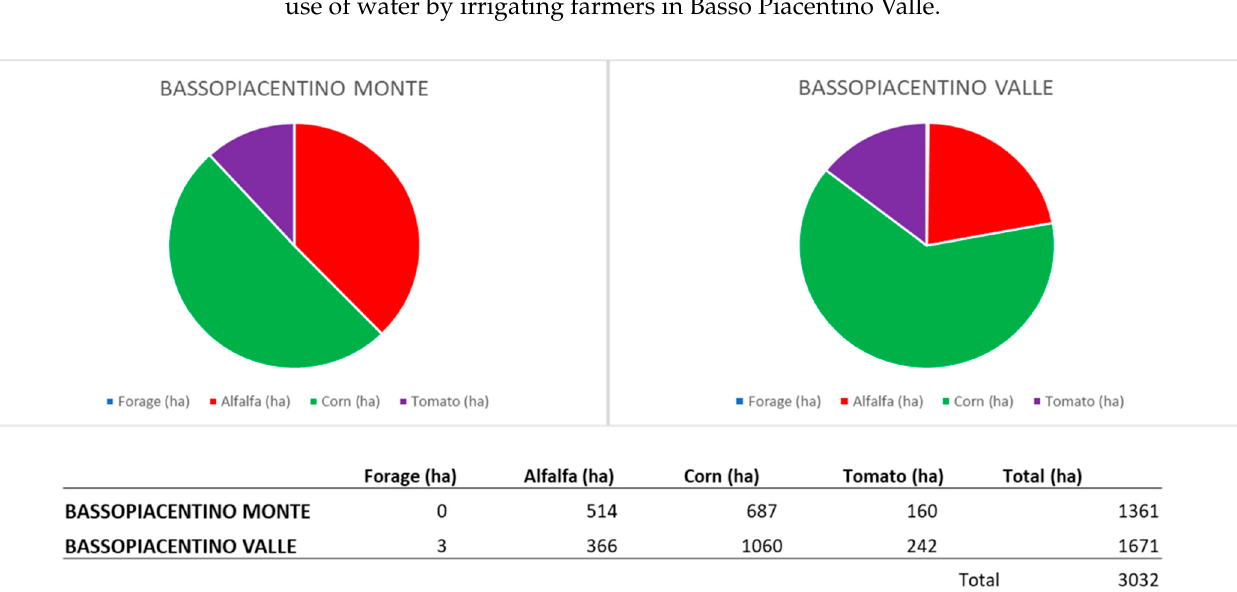
Figure A1. Overview of the two sub-districts for irrigation (north is in the top of the map).